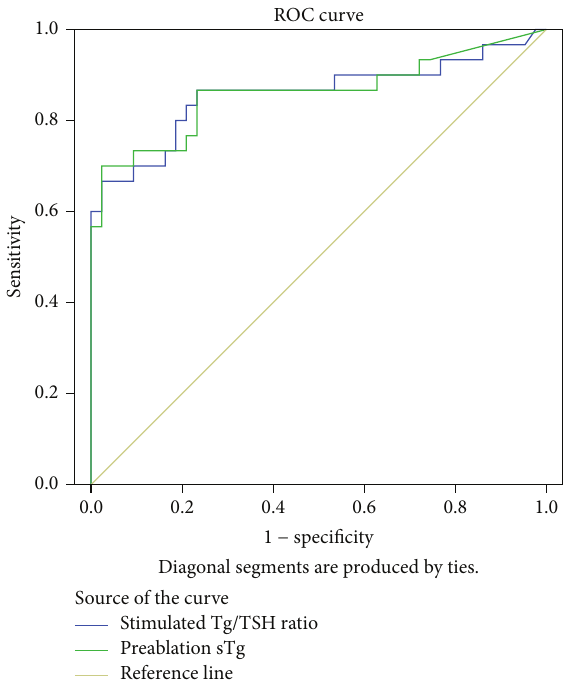
Figure 1: ROC curve of the accuracy of serum preablation sTg and sTg/TSH ratio in predicting unsuccessful